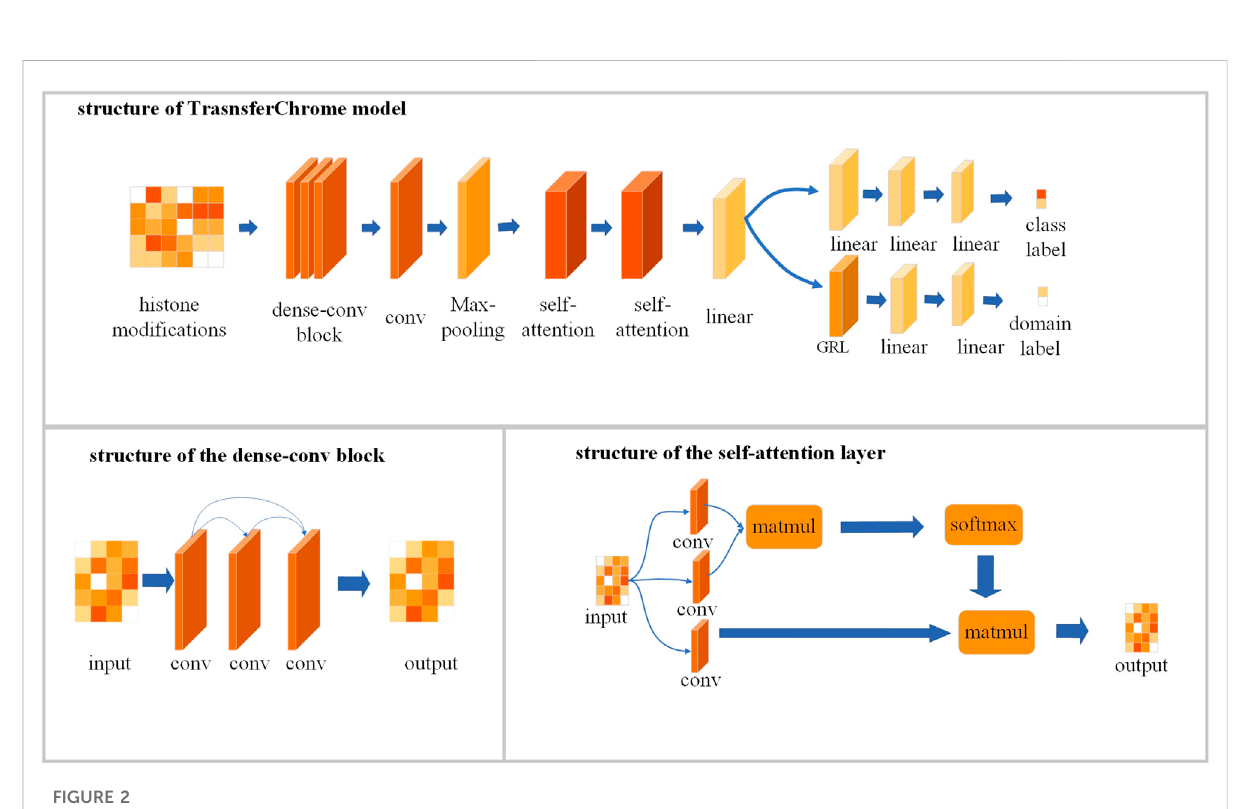
FIGURE 2 The model structure of